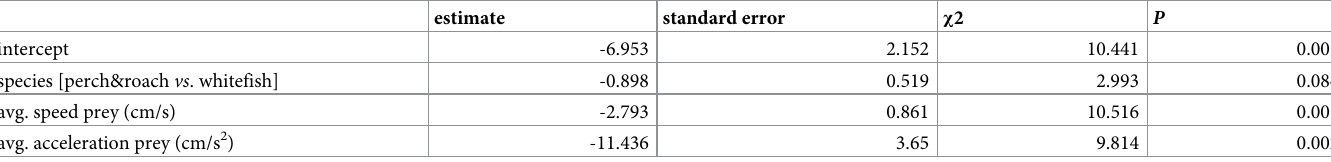
Table 2. Variables predicting the successful outcome of the predation from a predator’s